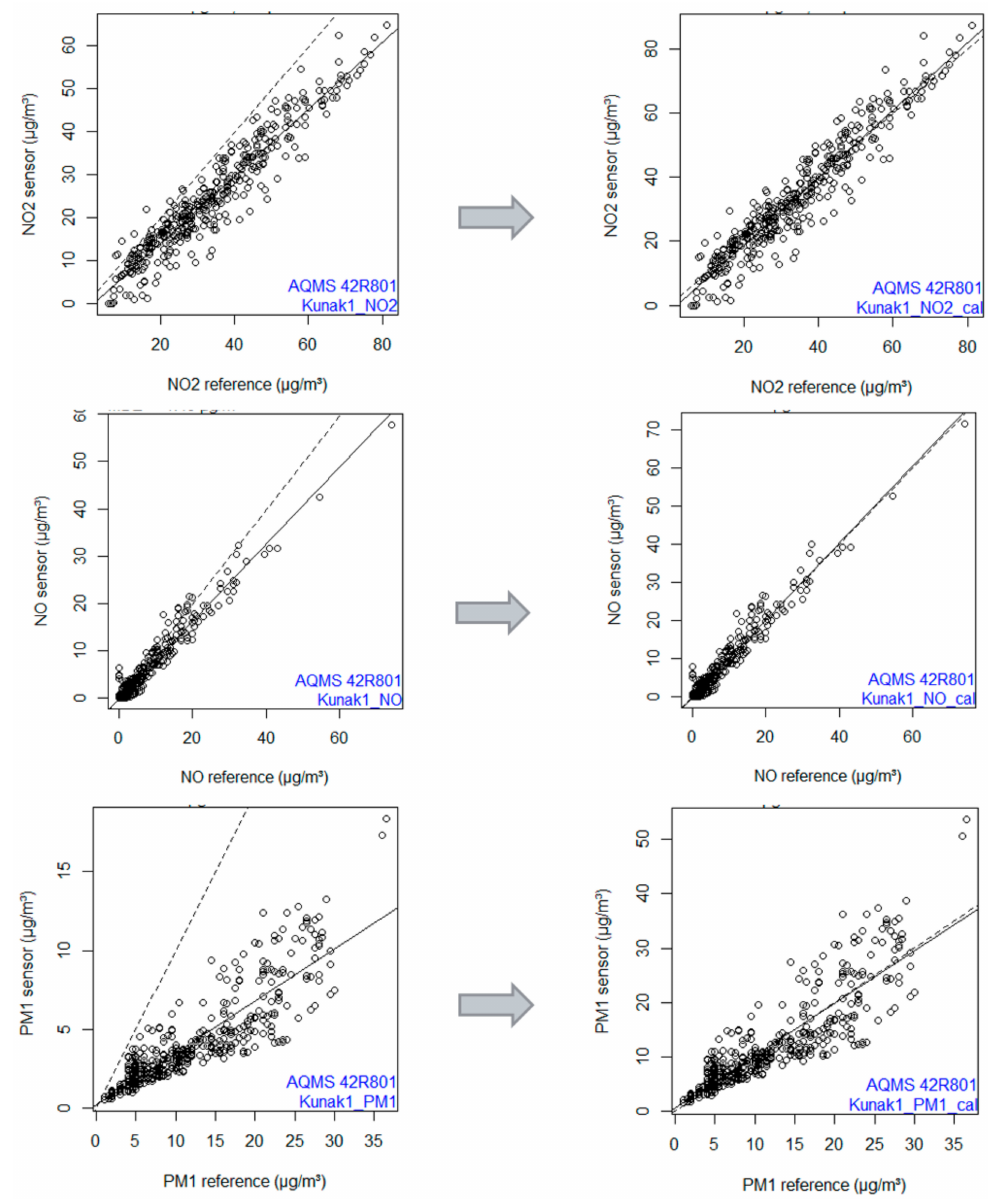
Figure 5. Effect of the local slope re-calibration on NO 2 (upper), NO (middle) and PM 1 (lower) data from Kunak 1 during co-location campaign 1. The recalibrated data (right) approximates the 1:1 line (dashed) much better when compared to the raw sensor data (left). Regression plots for all considered pollutants of both Konak and Airly are provided in Figure